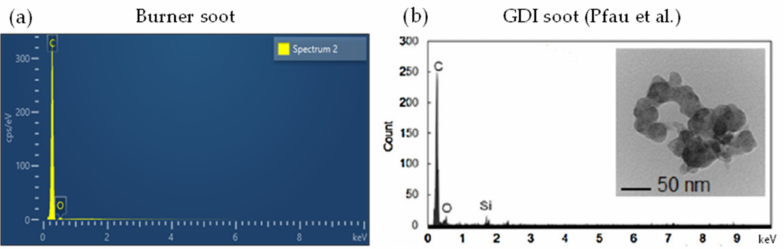
. m exh = 60 g/s, AFR = 0.95 and